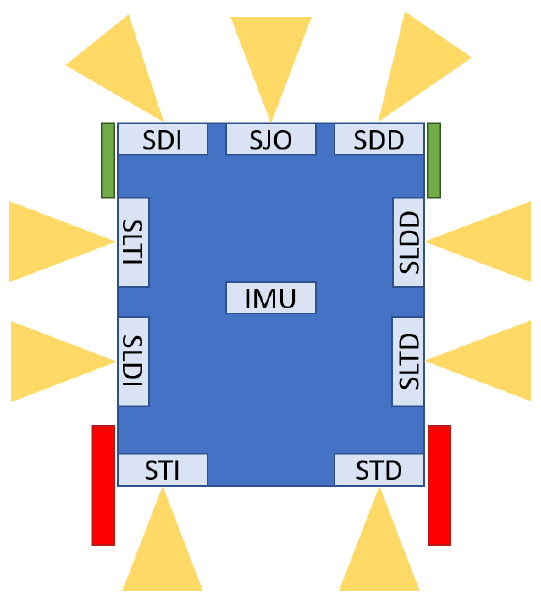
Figure 10. Sensor distribution on SARA.